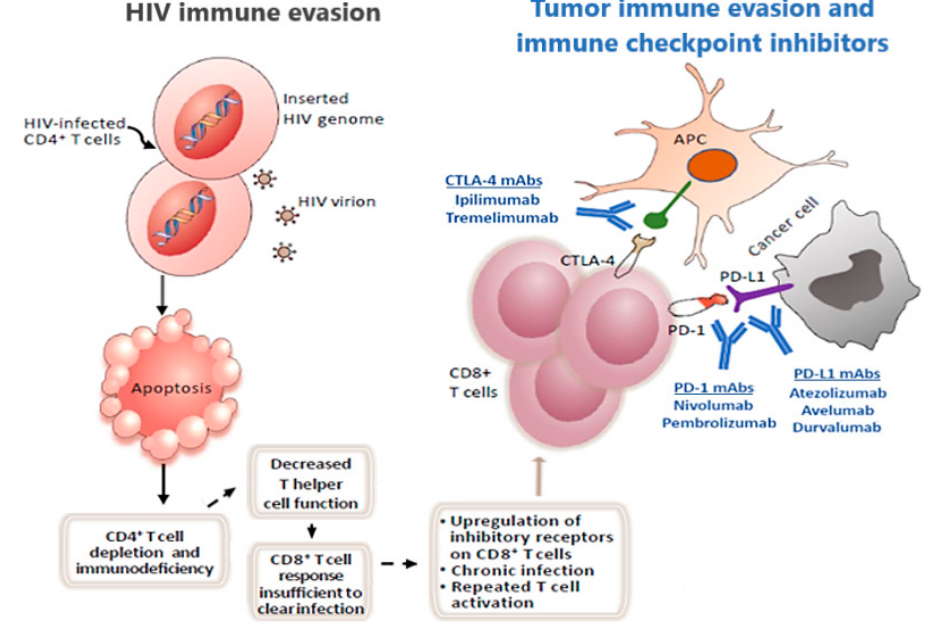
Figure 2. The T cell response to HIV infection, tumor immune evasion in HIV positive patients and immune checkpoint blockade. HIV infection lead both to a depletion and decreased function of CD4+ T cells. This phenomenon causes an insufficient anticancer cytotoxic T cell response and CD8+ T cells to upregulate their inhibitory receptors (iRs), thus increasing cancer risk and tumor immune evasion. Immune checkpoint inhibitors aim to revert cancer immune escape, acting on iRs expressed by tumor cell or by CD8+ T cells, thus that the use of these agents may be crucial for HIV infected people with cancer. CTLA-4: Cytotoxic T-Lymphocyte Antigen 4; mAbs: monoclonal antibody; PD-1: programmed cell death protein 1; PD-L1: Programmed death-ligand 1.